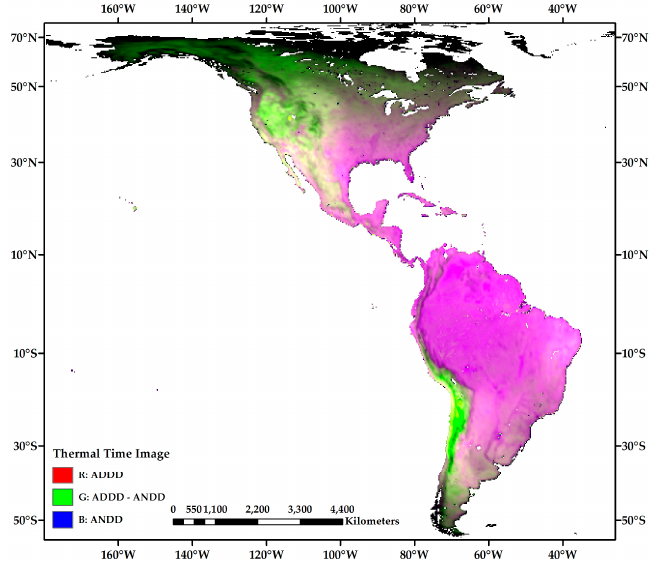
Figure 1. False-color composite of thermal time metrics for the Western Hemisphere.